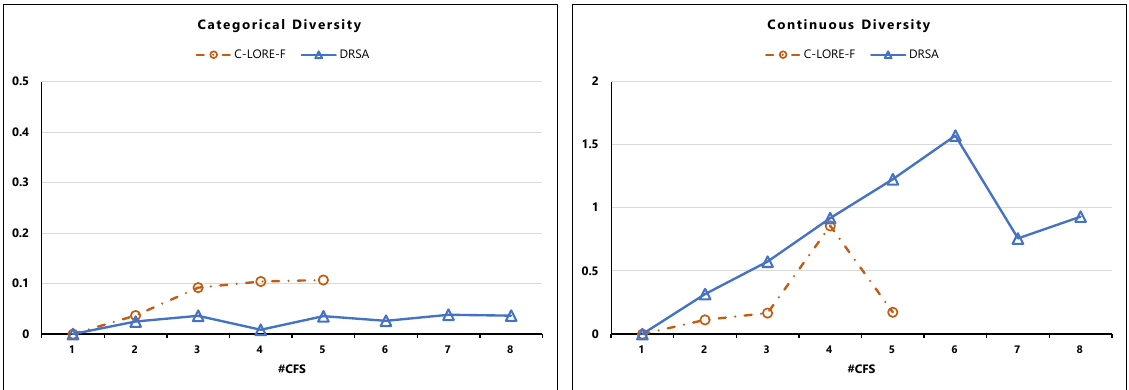
Figure 6. Diversity of counterfactual examples, in Categorical and Continuous attributes. The numbers in the y -axis represent the metrics values (the higher values the better performance), while the x -axis represents the number of generated counterfactual